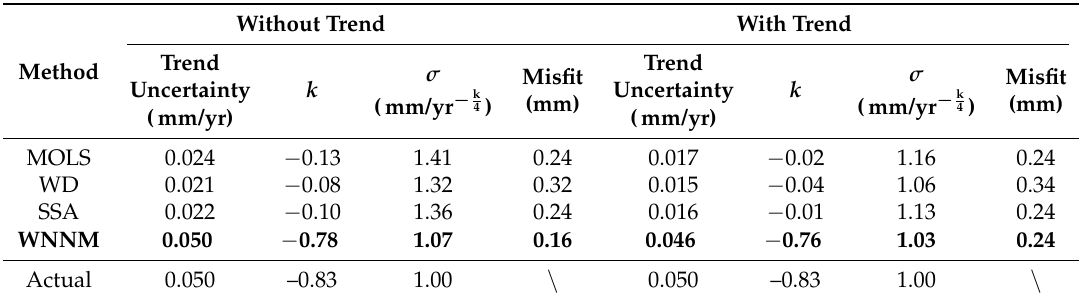
Table 3. Mean results of trend uncertainty, spectral index, noise amplitude and misfit estimated